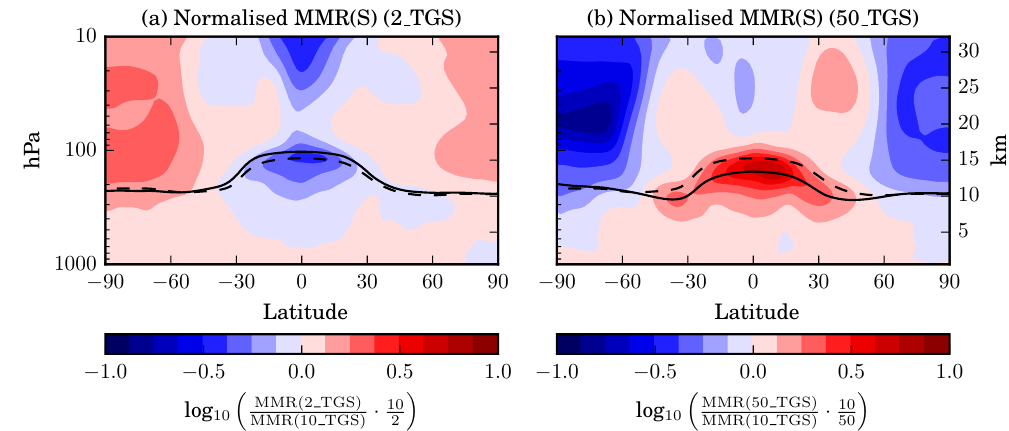
Figure 6. Latitude–height cross sections of the zonal and annual mean sulfate aerosol mass mixing ratio (a) for the 2_TGS and (b) for the 50_TGS experiment normalised by the value in the STANDARD (10_TGS) experiment and the ratio of the injection rates. The base-10 logarithm of the ratio is plotted as indicated below the colour scale so that positive (negative) values indicate larger (smaller) values than implied by a linear scaling. The mean tropopause level in the experiment is indicated by a solid line and the tropopause in the STANDARD simulation by a dashed